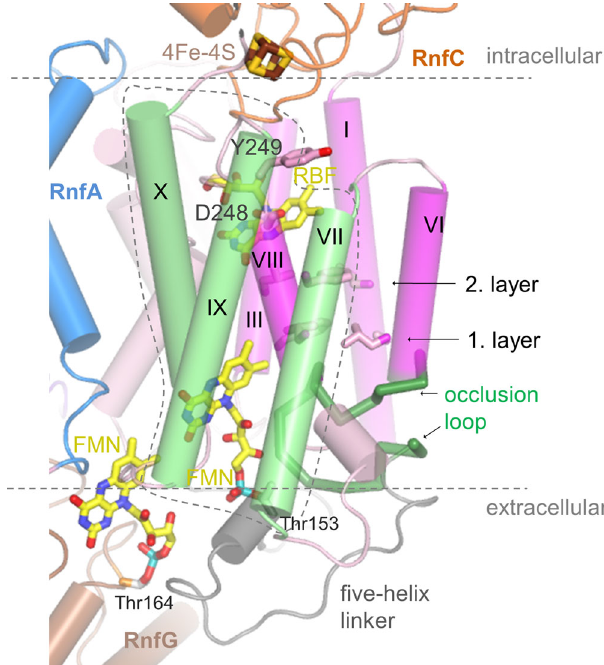
Fig.4|TheNa + passage. IntheRnfstructurethepotentialNa + channelisfoundina locked state. The constriction between helices I, III, VI, and VIII (magenta) of RnfD subdividedintotwohydrophobiclayersmightbeopenedduringturnoverbasedon fi ndings of architecturally similar transporters; however, alternative passages are possible. The extracellular half-channel is occluded by a loop (dark green) and the cytoplasmic half-channel presumably placed next to Asp248 is rather elusive. FMN RnfD isinETdistancetoFMN RnfG andRBF.Attheextracellularside,asmallhelix 230:235 (salmon) arranged nearly parallel to the membrane plane precedes helix VIII(hotpink).ThelattercontactstheisoalloxazineringbyGly237.HelicesVII, IX,X (green), and VIII (encircled by a dashed line) may move in a concerted fashion to open a passage for Na + transport. The Thr153 and Thr164 hydroxy groups form a covalent bond with the phospho groups of FMN RnfD and FMN RnfG ,